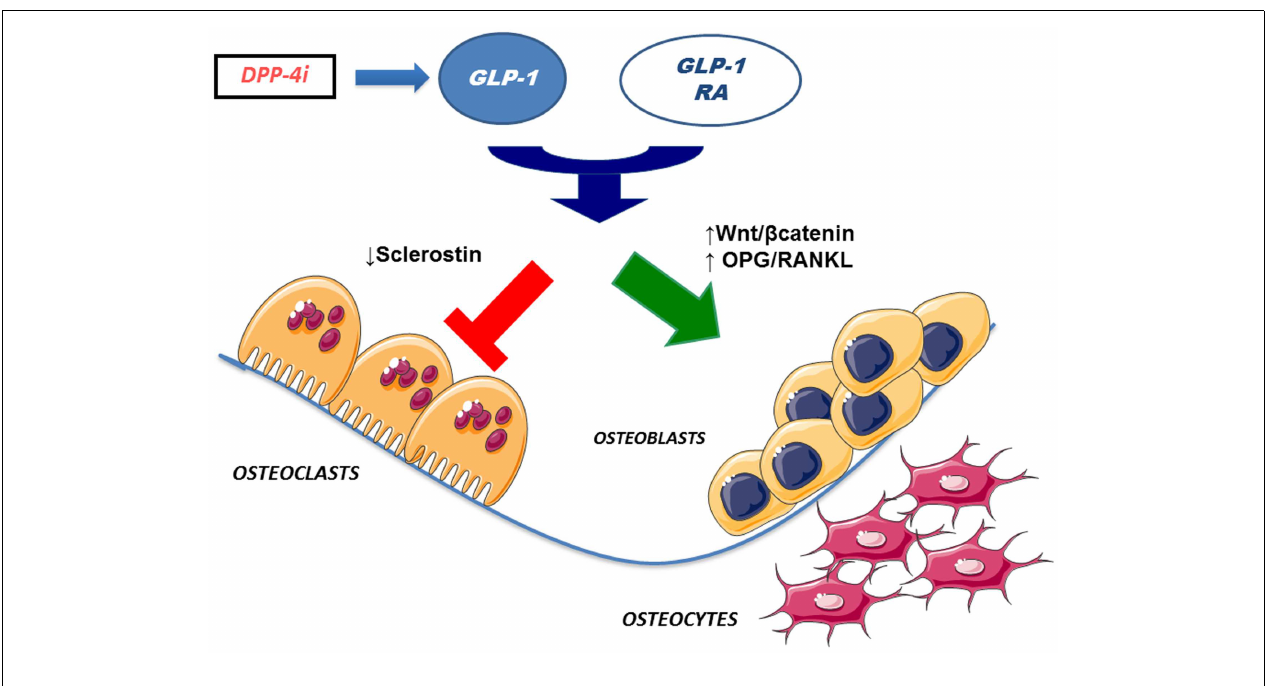
OPG/RANKL ratio. In addition, osteoclastogenesis inhibition has been suggested to be mediated by reduced sclerostin levels. GLP-1 RA, GLP-1 receptor agonists; DPP4i, dipeptidyl peptidase-4 inhibitors; OPG, osteoprotegerin; RANKL, receptor activator of nuclear factor kappa-B